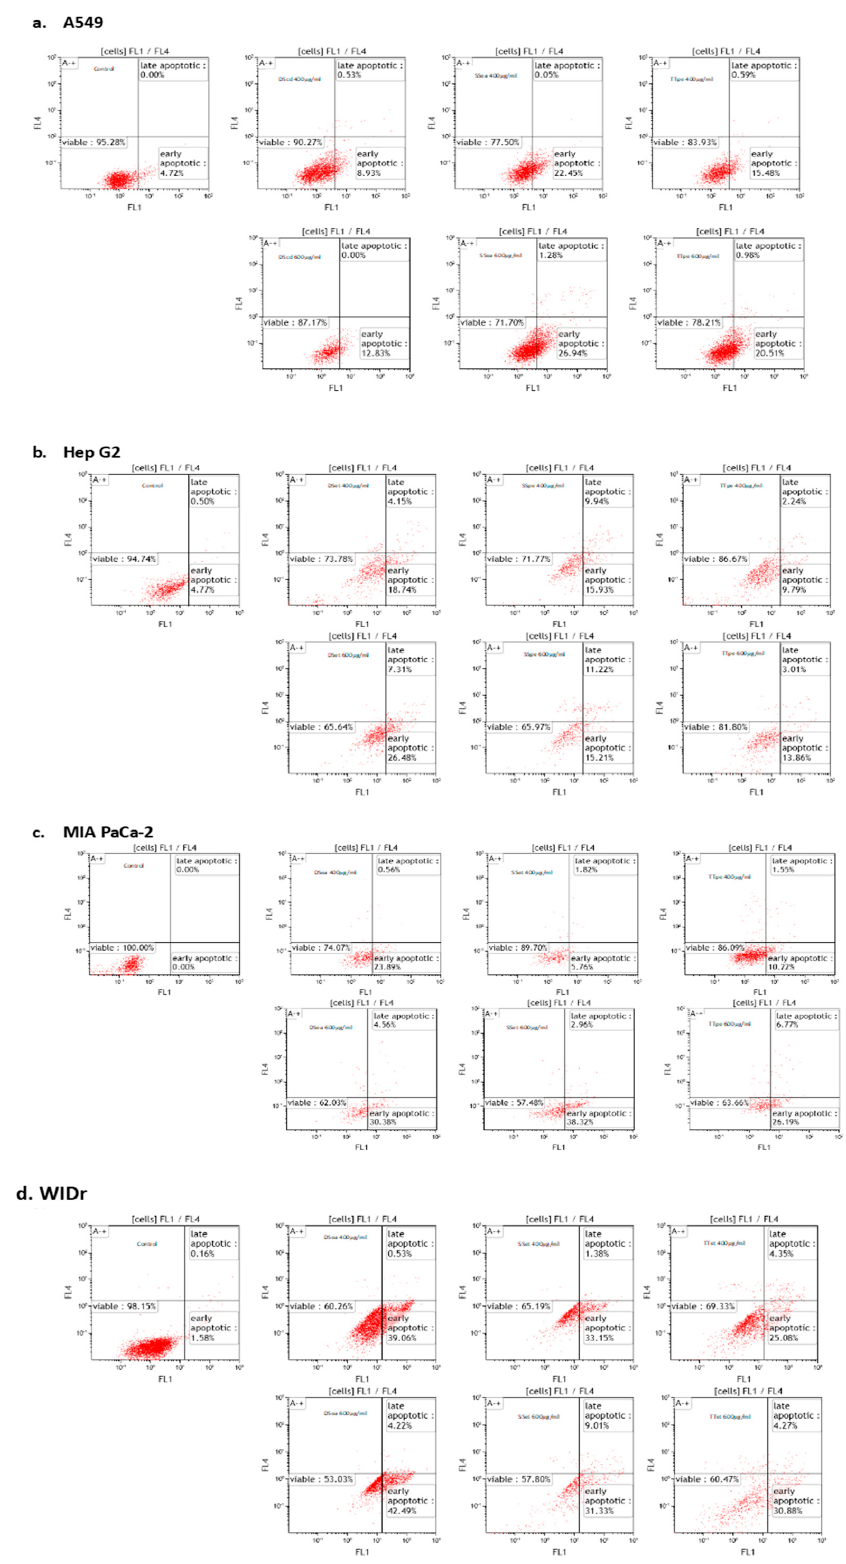
Figure 3. Induction of early apoptosis in A549, Hep G2, MIA PaCa-2, and WiDr cells by NZ surf clam extracts. Annexin V/Dead Cell Apoptosis Kit with Aleza ® Fluor 488 annexin V and PI determined the percentage of early apoptotic cells, examined by flow cytometry. Each experiment was carried out twice, in duplicate. Data are represented as mean ±